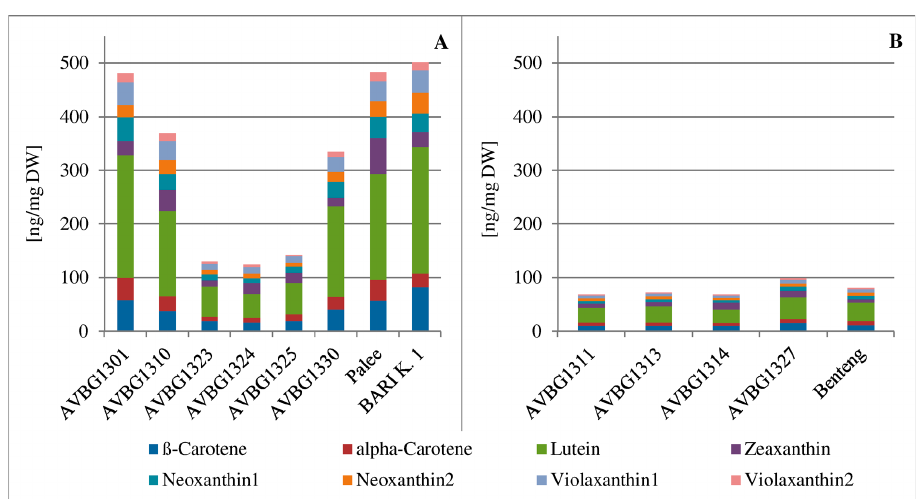
Fig. 4: Intensity distributions of carotenoids in eight South Asian (A) and five Southeast Asian (B) type bitter gourd entries cultivated in a greenhouse in Karlsruhe, Germany. BARI K. 1 = ‘BARI Karella 1’. 10 fruits per entry.